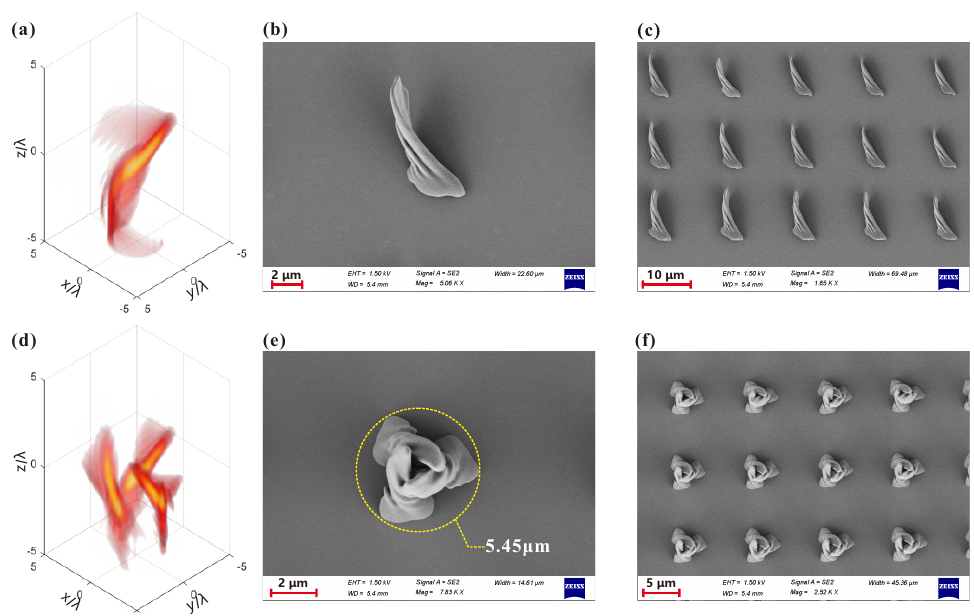
Figure 6. The 3D structure of light field of the MHCBs and corresponding fabricated chiral structure. The 3D intensity distribution of the MHCBs with ( a ) m = 1, α = 6 and ( d ) m = 3, α = 6. SEM photos of the fabricated 3D chiral microstructures via tightly focused MHCBs with ( b ) m = 1, α = 6 and ( e ) m = 3, α = 6. SEM photos of the fabricated 3D chiral microstructures array via MHCBs with ( c ) m = 1, α = 6 and ( f ) m = 3, α = 6.